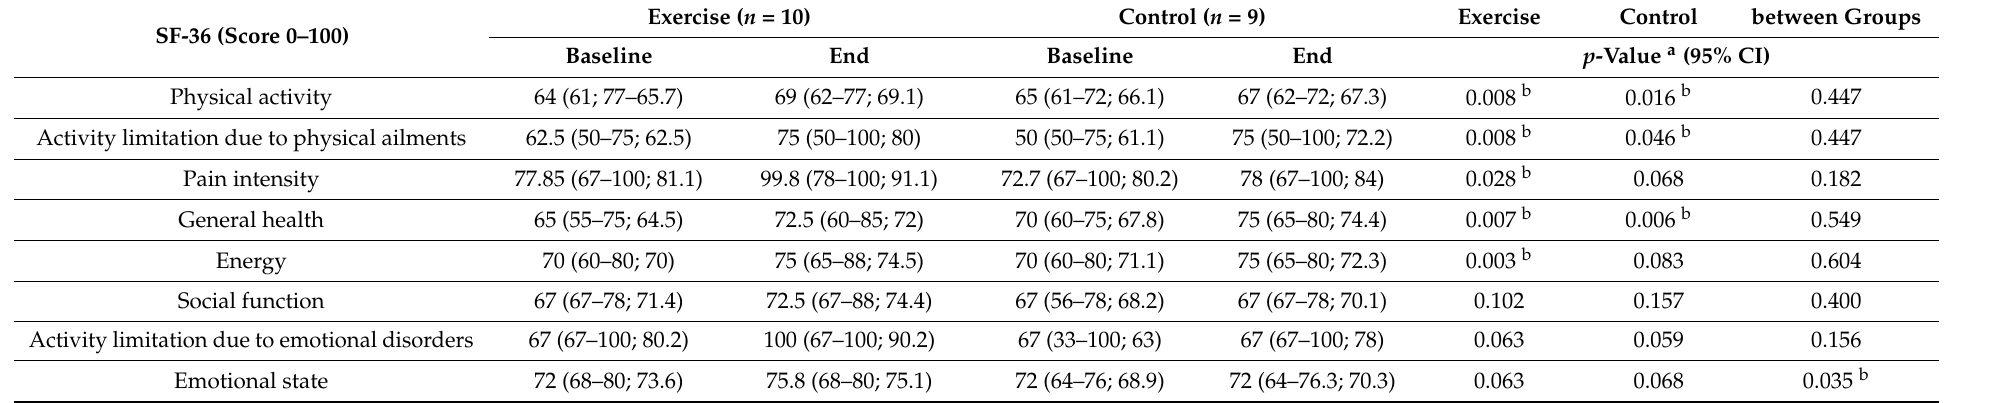
Table 4. Results of quality of life in individuals with migraine in groups.